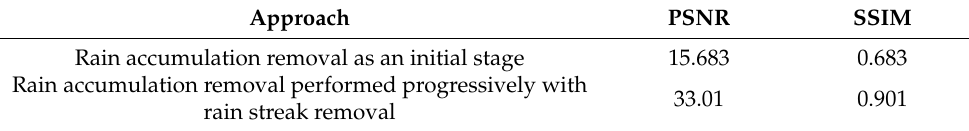
Table 2. Effect of applying rain accumulation removal as pre-processing vs. applying it